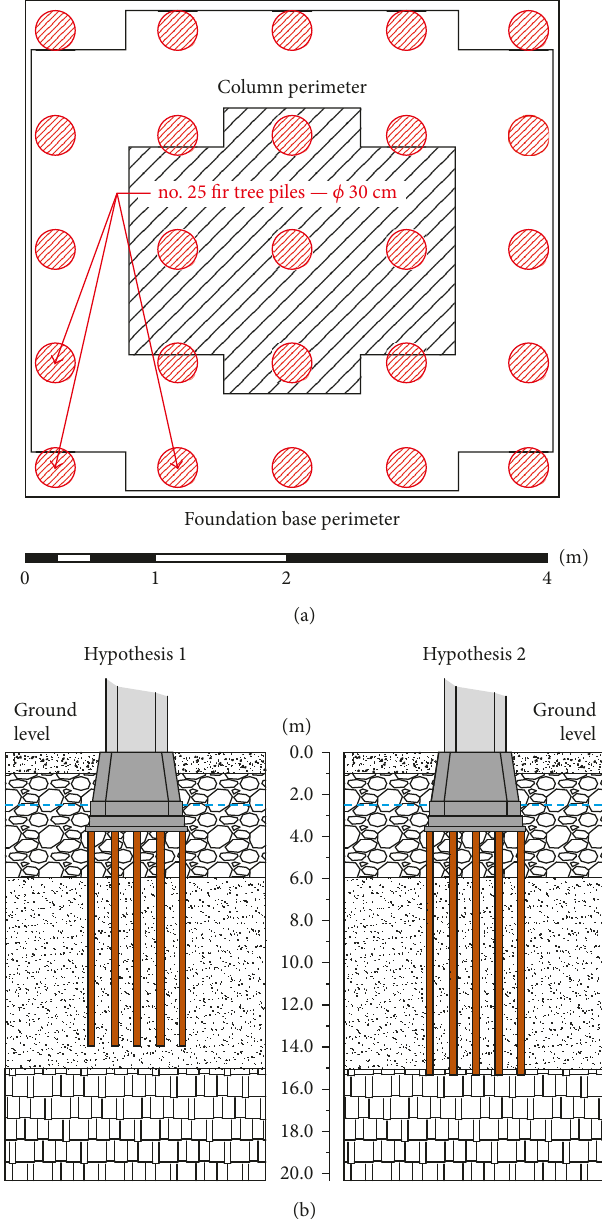
Figure 7: Wooden piles-pad footing foundation system: (a) plan of a typical column foundation with the piles position; (b) two dif- ferent hypotheses about the pile length leading to floating piles (hypothesis 1) and end-bearing piles (hypothesis 2)